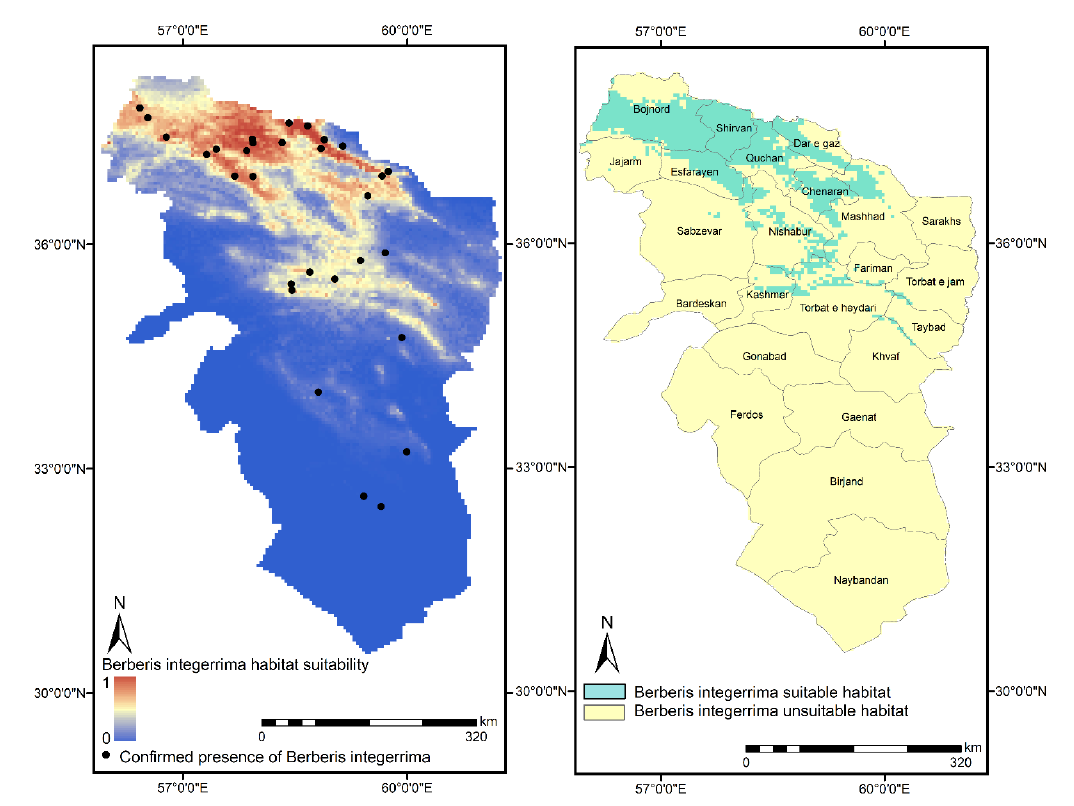
Fig. 5: Habitat suitability of Berberis integerrima and its suitable habitats in the cities of Khorasan region.